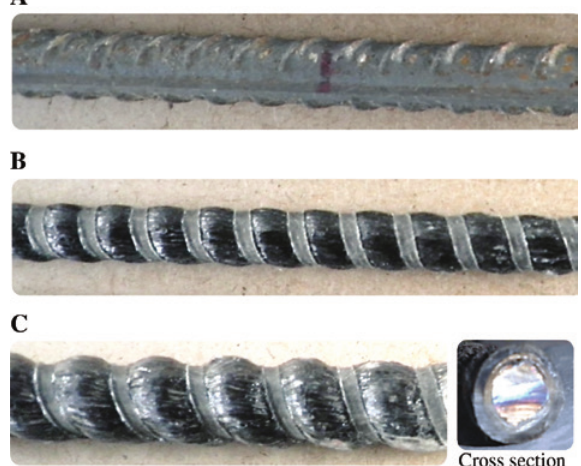
Figure 1: Longitudinal reinforcing bars in this study. (A) Steel bar, (B) BFRP bar and (C)